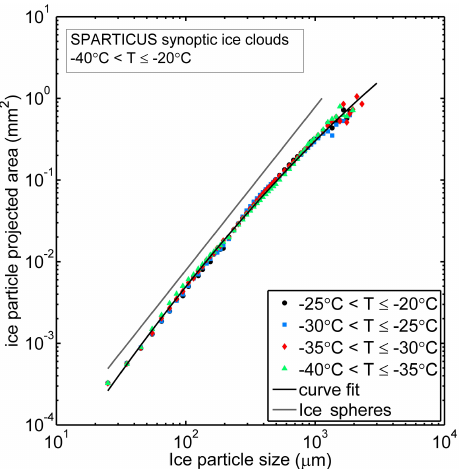
Figure 7. The m/A ratio for ice particles normalized by the corre- sponding m/A ratio for ice spheres using the m - D and A - D curve fits appropriate for the indicated temperature regime. The blue curve is based on Tables 1 and 2, but the black curve is only based on 2D-S